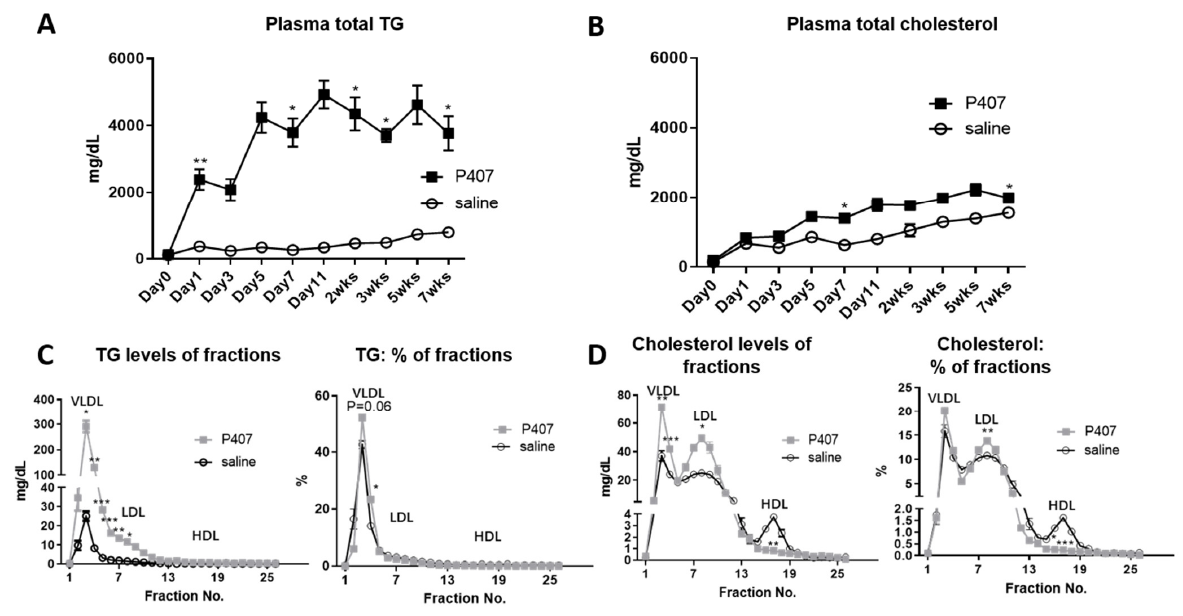
Figure 1. Plasma lipid levels of Ldlr –/– mice on the Western diet with injection of P407 or saline control. Ldlr –/– mice were fed the Western diet and injected with P407 or saline every other day. Plasma levels of total ( A ) TG and ( B ) cholesterol were measured in mice just prior to (day 0) and during P407 or saline injection. At 7 weeks of P407 or saline injection, ( C ) TG and ( D ) cholesterol distributions of lipoprotein fractions were analyzed by SEC analysis. n = 7 mice/group. Values are mean ± SEM. Two-way ANOVA with repeated measures and assumption of inequivalence of vari- ance followed by Šídák’s multiple pairwise comparisons test was used for statistical analysis. * p < 0.05, ** p < 0.01, and *** p < 0.001 compared to saline controls. Analysis of the SEC fractions revealed that TG levels in VLDL and LDL were higher in Ldlr –/– mice receiving P407 versus the saline control (Figure 1C). As expected, in both